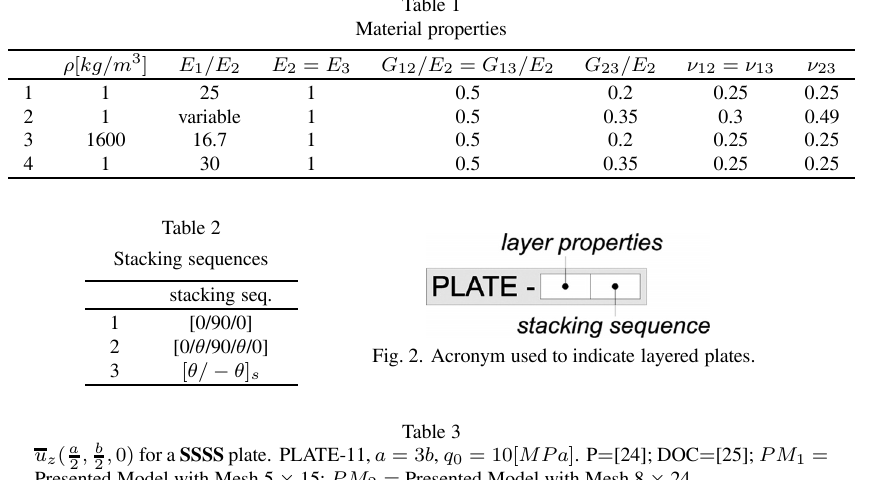
Fig. 2. Acronym used to indicate layered plates.